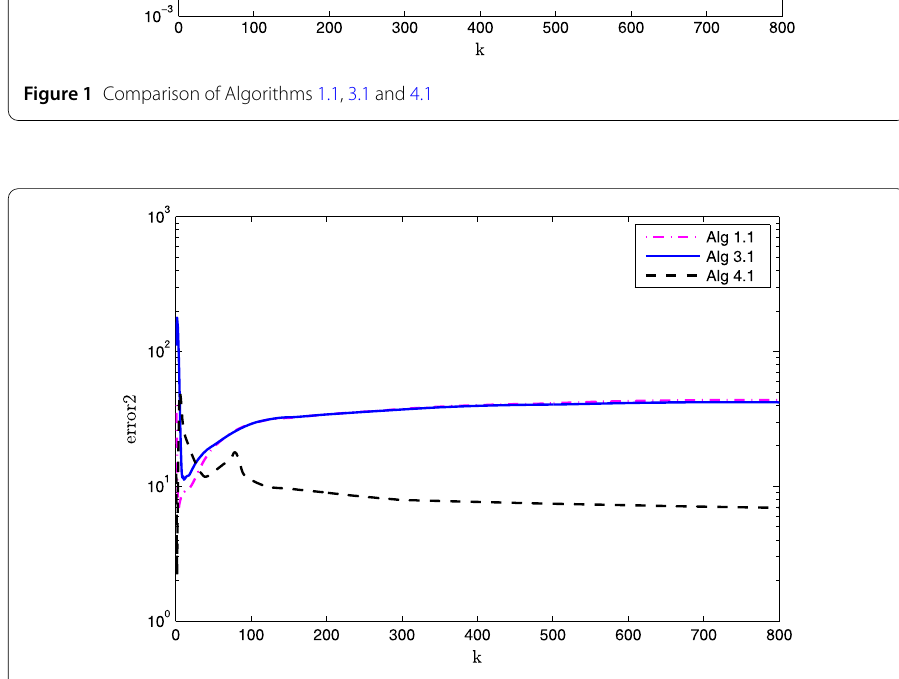
Figure 2 Comparison of Algorithms 1.1, 3.1 and